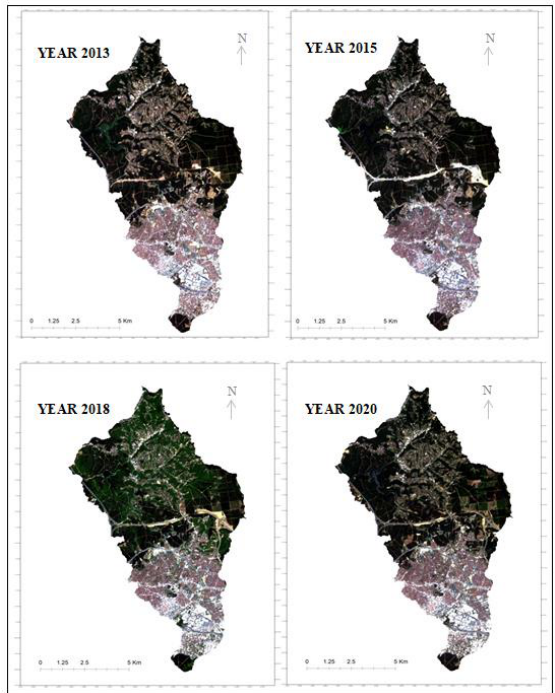
Figure 1. Landsat-8 Satellite Images Used in the